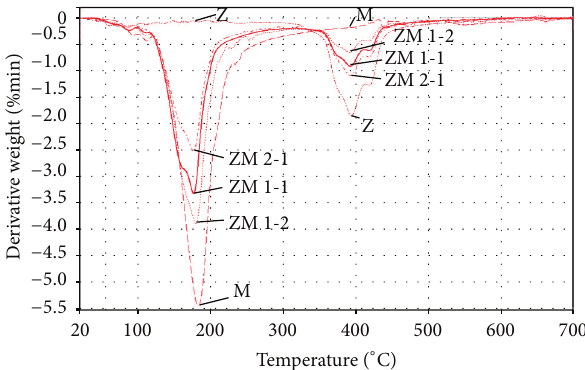
Figure 8: DTG of the synthesised optimum phases of the magne- sium and zinc borates and mixtures of the magnesium and zinc borates.